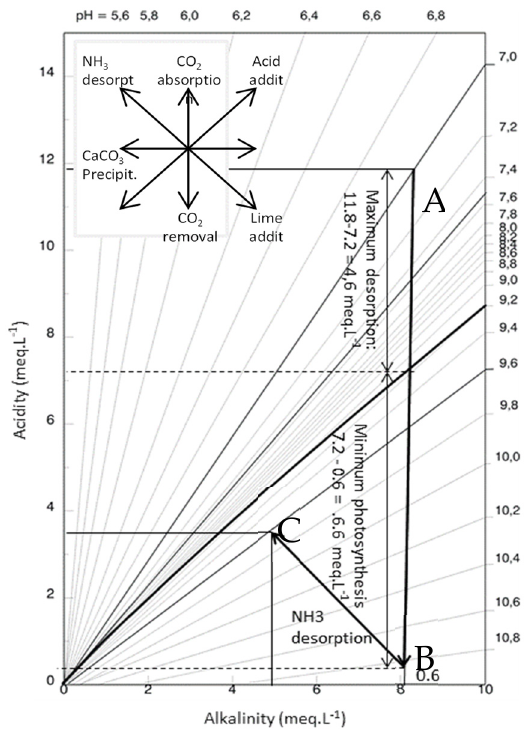
Figure 2. Deffeyes diagram (temperature of 25 ◦ C: pK 1 = 6.33, pK 2 = 10.33, pK w = 14).